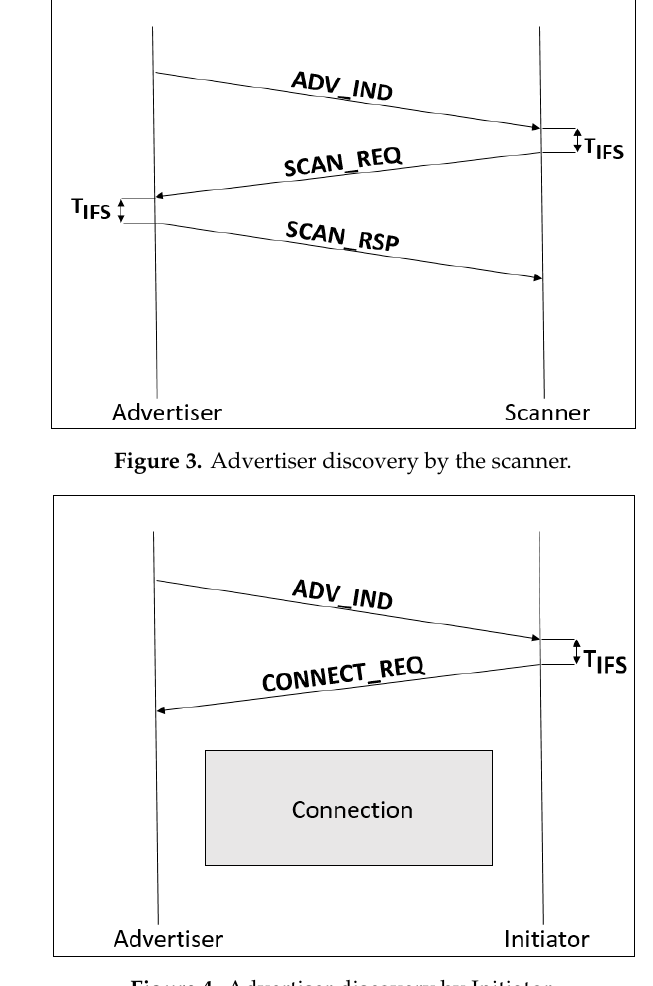
Figure 4. Advertiser discovery by Initiator.